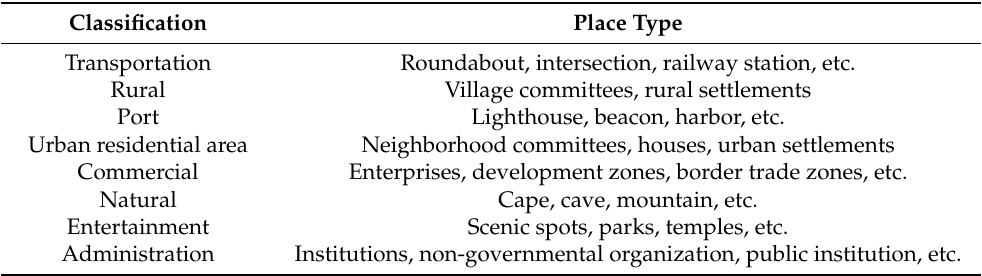
Table 2. Classification of the different place names according to the type of place. Classification Place Type Transportation Roundabout, intersection, railway station, etc. Rural Village committees, rural settlements Port Lighthouse, beacon, harbor, etc. Urban residential area Neighborhood committees, houses, urban